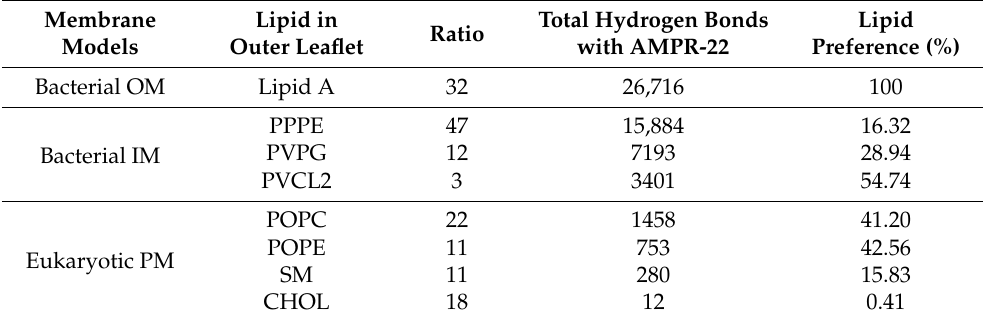
Table 2. Lipid preference of